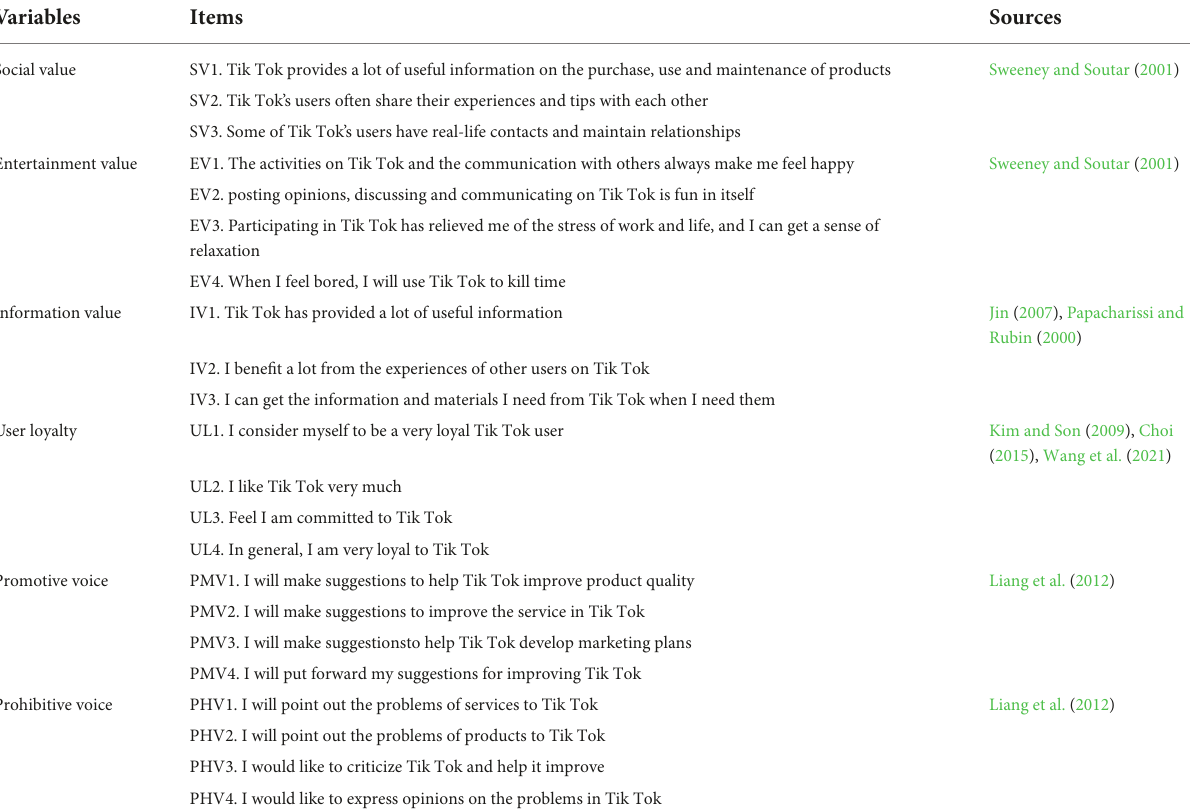
TABLE 1 Variables and measurement